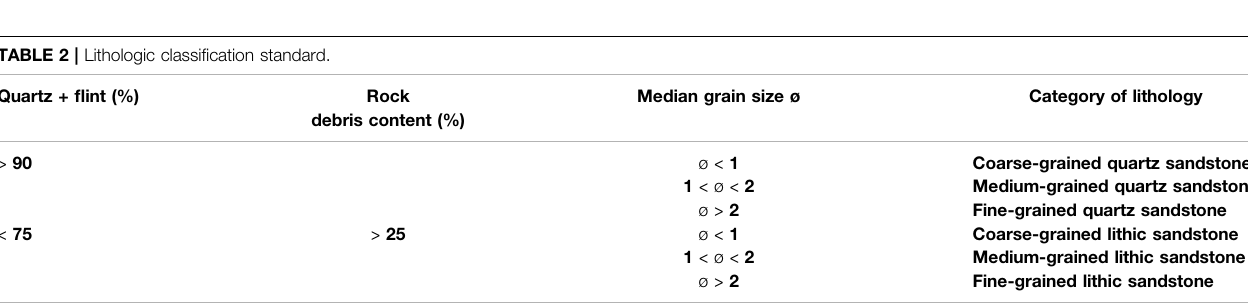
They are the basis for dividing lithology by component